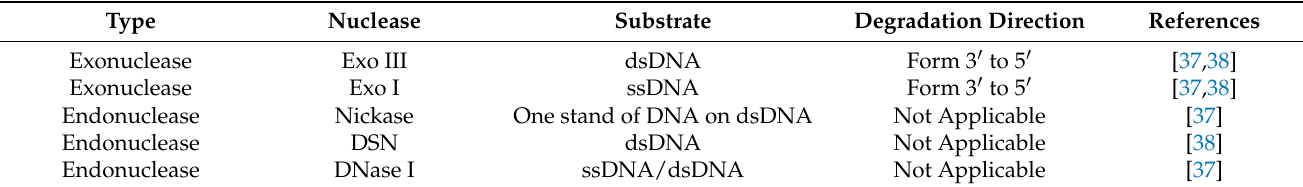
Table 1. The functions of different nucleases mentioned in this review